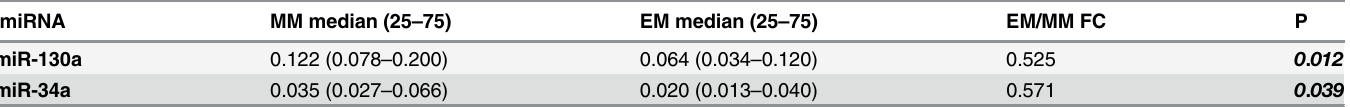
Table 3. MiRNA levels in a validation cohort of patients. Data are presented as median of normalized miRNA expression and interquartile range. Mann- Whitney U test was used to compare the values. Fold change (FC) between extramedullary myeloma disease (EM) patients versus multiple myeloma (MM) patients and p values are presented. Significant values p < 0.05 are marked with bold and italics.